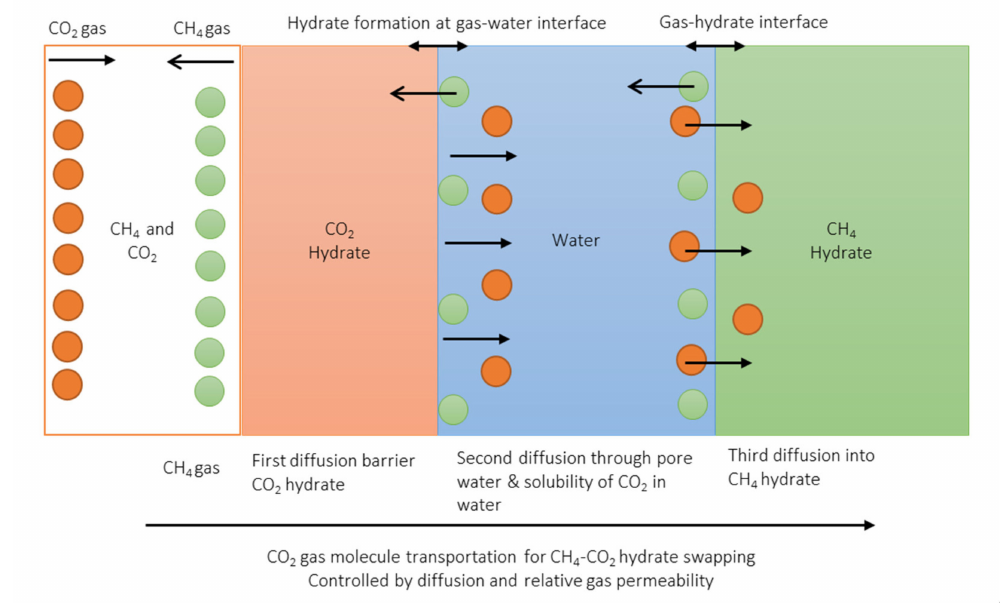
Figure 1. Conceptual layout of the transport of CO 2 gas molecule through di ff erent media and of the decrease in gas concentration arriving at CH 4 hydrate